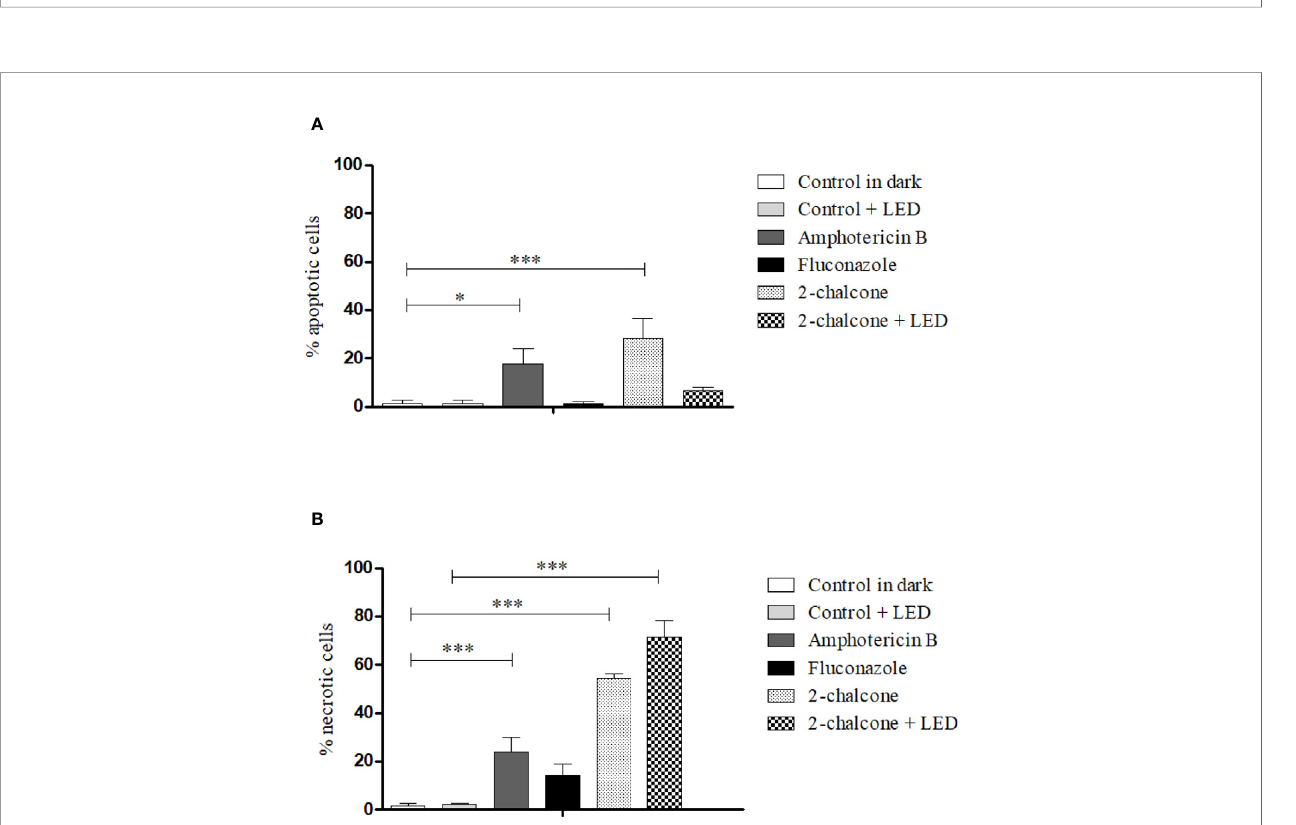
FIGURE 10 | Mechanism of death due to apoptosis (A) and necrosis (B) induced after treatment of T. rubrum ATCC 28189 with 2-chalcone in the dark and with 2-chalcone mediated PDT (2-chalcone +LED), compared with the untreated control. Further, 2-chalcone in the dark and amphotericin B induced cell death by both apoptosis and necrosis, whereas 2-chalcone +LED only induced death by necrosis. *p < 0.05; ***p <